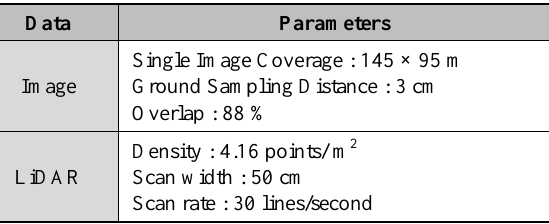
Table 2. Data acquisition results from the integration test